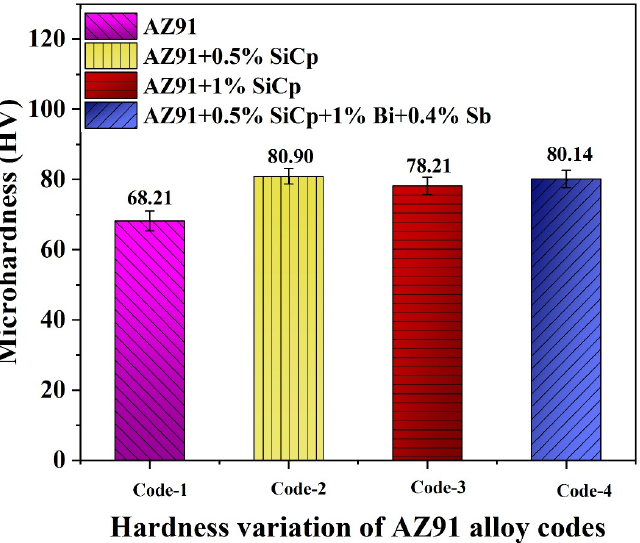
Figure 3. Microhardness of AZ91 alloys with different hybrid nano- and micro-reinforcements. Table 3. Microhardness variation and increment in microhardness of the alloy codes compared with pure AZ91 alloy. Alloy